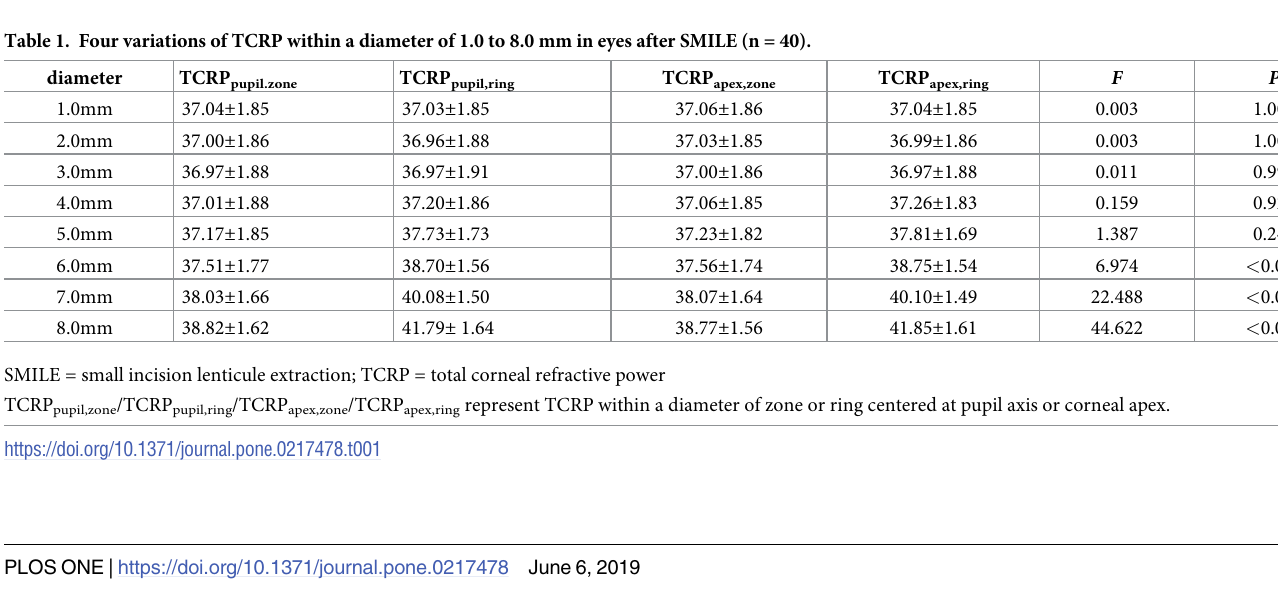
Table 1. Four variations of TCRP within a diameter of 1.0 to 8.0 mm in eyes after SMILE (n = 40). diameter TCRP pupil.zone